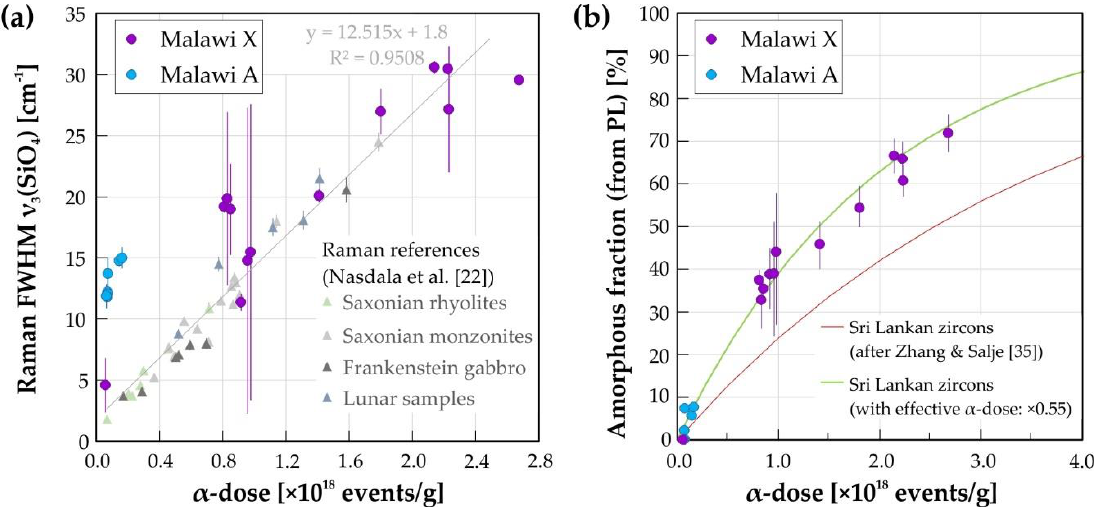
Figure 9. ( a ) Raman ν 3 (SiO 4 ) band widths of the Malawian samples (X, A) plotted against the α-dose calculated from the age of the samples and the U and Th concentrations (Table A2) obtained from multiple LA-ICP-MS measurement spots (indicated in Figure 7). ( b ) The amorphous fraction f a as determined from the PL of Dy 3+ from same measurement spots. The correlation f a vs. α-dose of Sri Lankan zircon according to the direct impact model after Zhang and Salje [35] is given as red curve (cf., Figure 5a). An additional (green) curve represents this correlation with Sri Lankan α-doses corrected with a factor of ×0.55 (B a = 4.96 × 10 −19 g) that accounts for geothermal annealing and represents the ’effective’ dose Sri Lankan zircon samples have experienced.